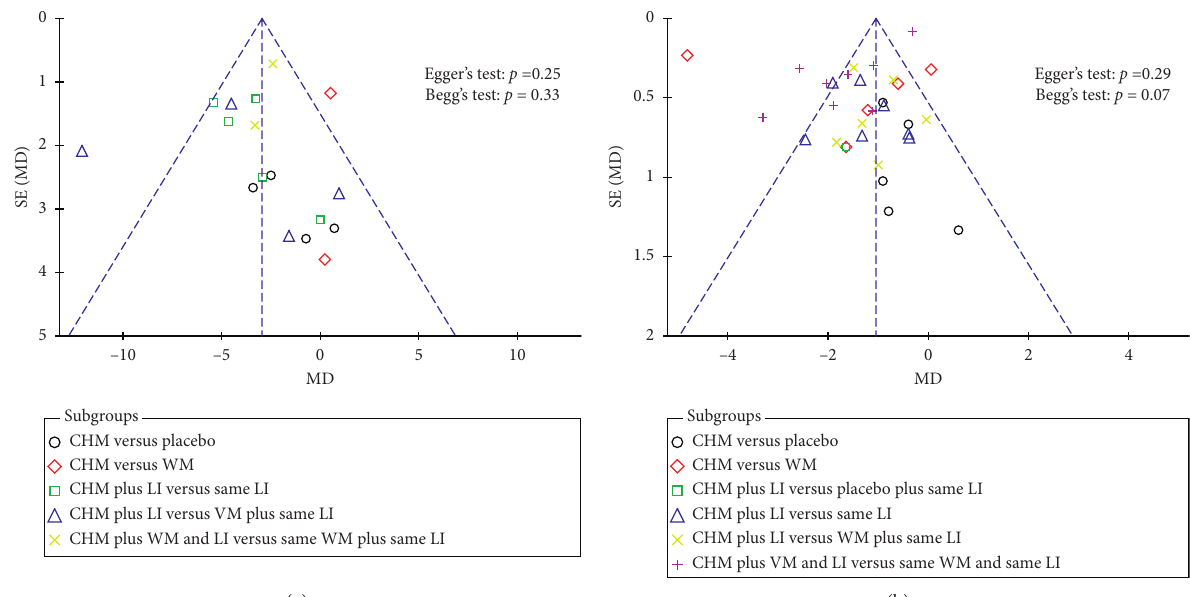
Figure 6: Funnel plots for overall (a) body weight (kg), and (b) body mass index (kg/m 2 ) of included studies based on subgroups, represented within 95% confidence limits. CHM, Chinese herbal medicine; LI, lifestyle intervention; MD, mean difference; SE, standard error; WM, Western